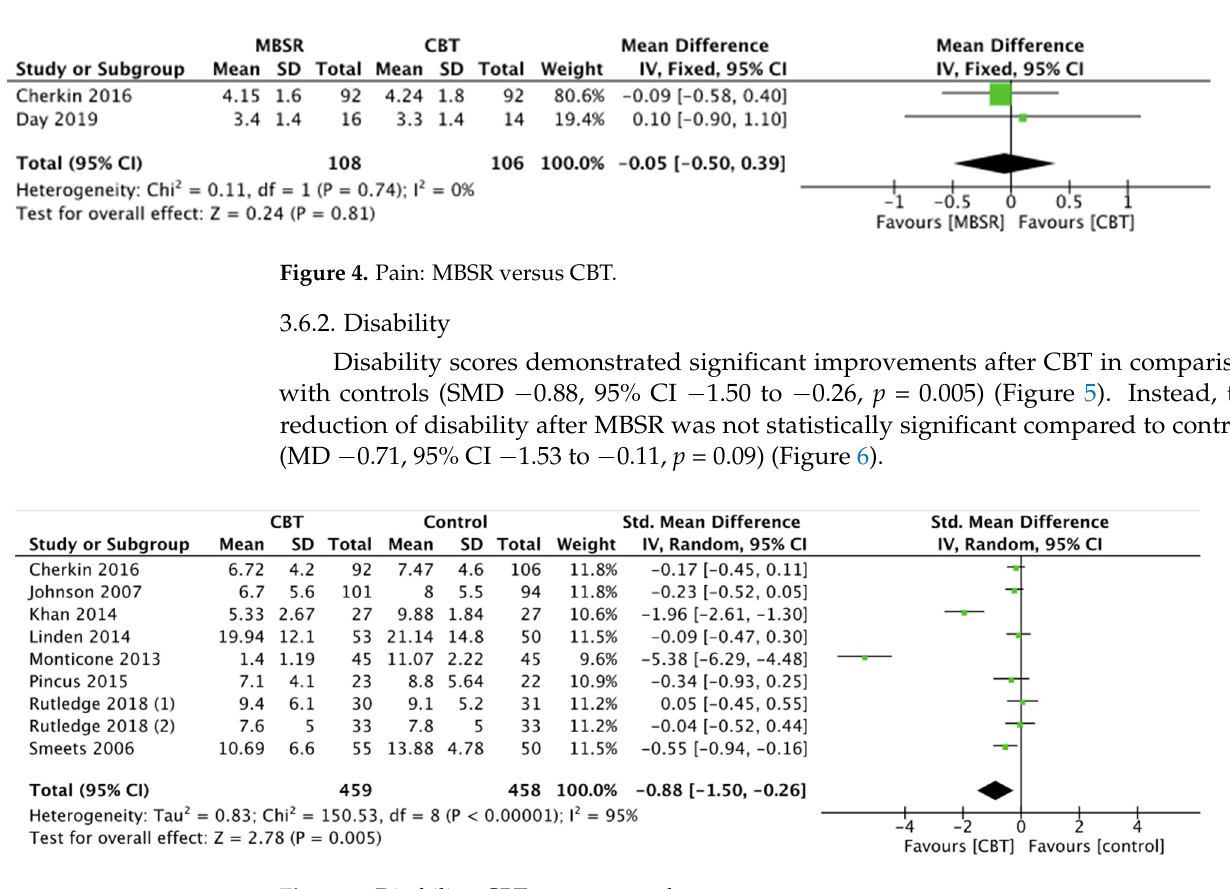
Figure 3. Pain: MBSR versus control.